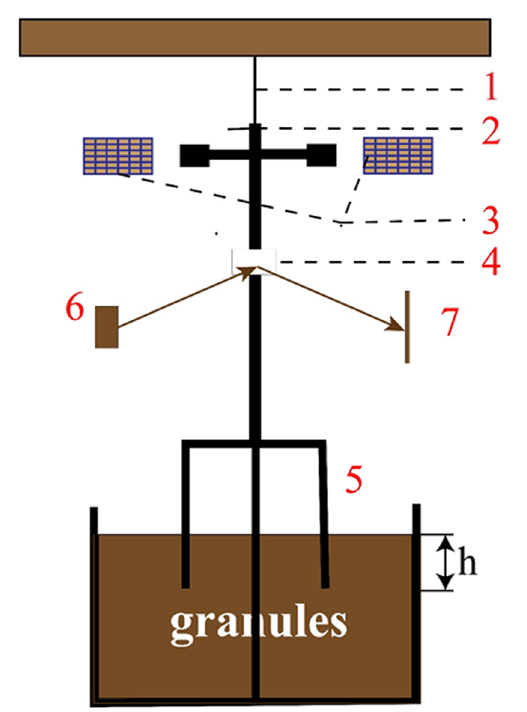
Fig. 1. Sketch of the forced torsion pendulum immersed into a granular material.1, suspension wires; 2, permanent magnet; 3, external coils; 4, mirror; 5, cylinder (made of aluminum alloy with inner radius R) covered or not by a fixed layer of granules; 6, optic source; 7, optic